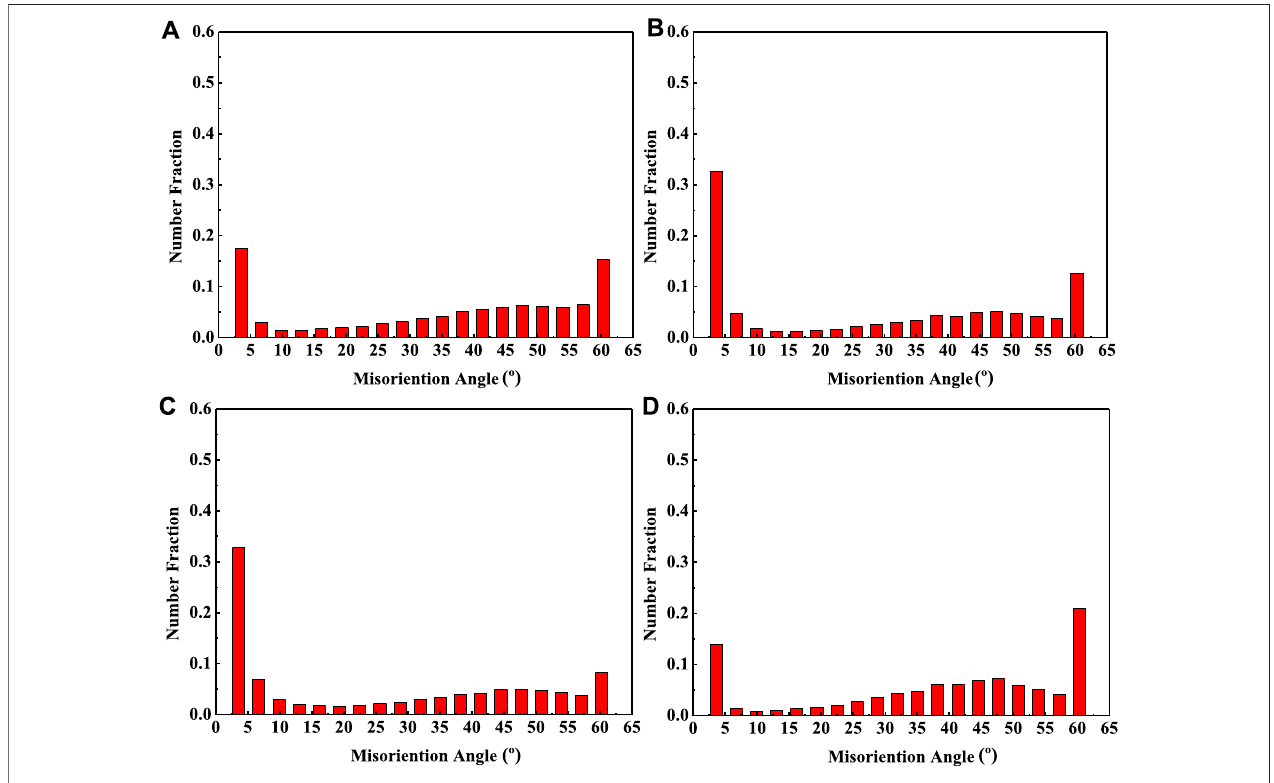
FIGURE 7 | Misorientation distribution histogram at different strain rates with the temperature of 1,100 ° C: (A) 0.01 s − 1 , (B) 0.1s − 1 , (C) 1 s − 1 , and (D) 10 s − 1 .